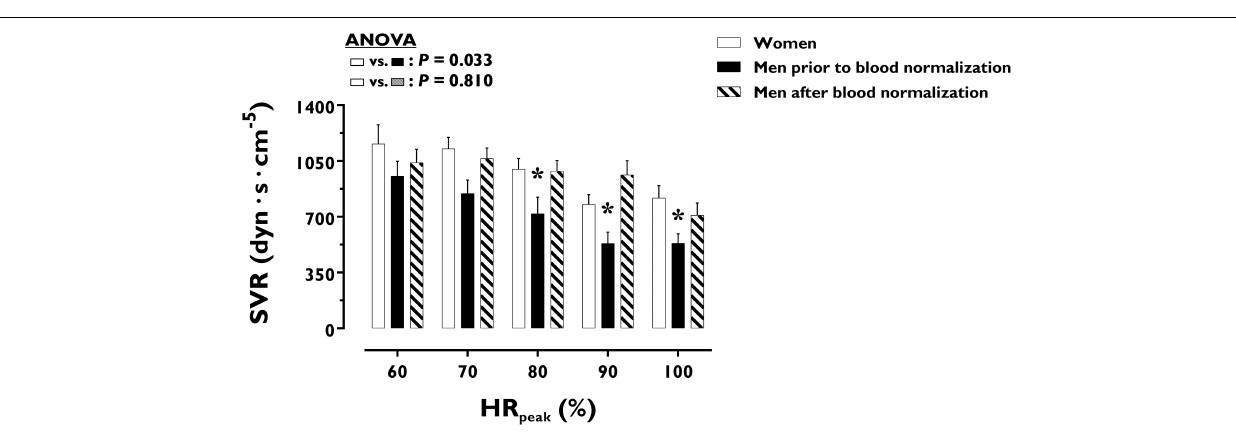
Figure 4 . At any specific relative exercise intensity, O 2 uptake was reduced in women compared with men before blood normalization ( P = 0.010). After blood normalization, there was no sex difference in O 2 uptake during exercise ( P = 0.159). VO 2 peak was similar in women and men after